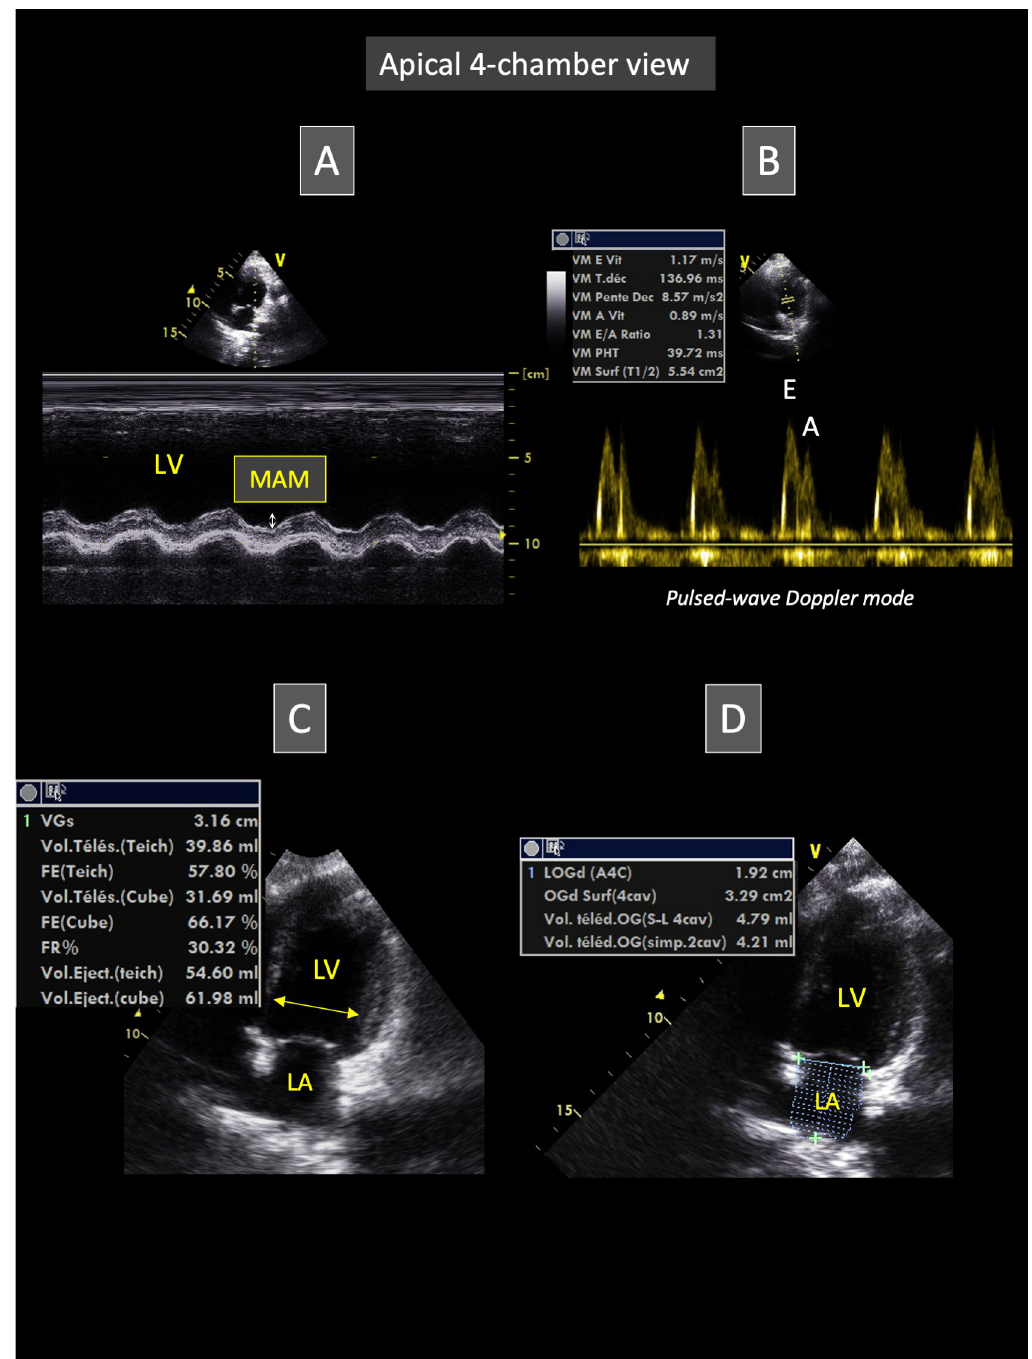
Fig 2. Representative apical 4-chamber view obtained from Borneo orangutans involved in the study. This view allows to place the M-mode cursor through the lateral mitral annulus for measurement of mitral annular motion (MAM, A) and to obtain transmitral flow recordings using pulsed-wave Doppler mode (B). Video loops of this view can also be used for left ventricular (C) and left atrial measurements (D). Fig 2C and 2D respectively show measurements of the end-systolic left ventricular diameter and end-diastolic left atrial volume (see text for explanation). E and A : peak velocity of early and late diastolic transmitral flows , respectively; LA : left atrium; LV : left ventricle .